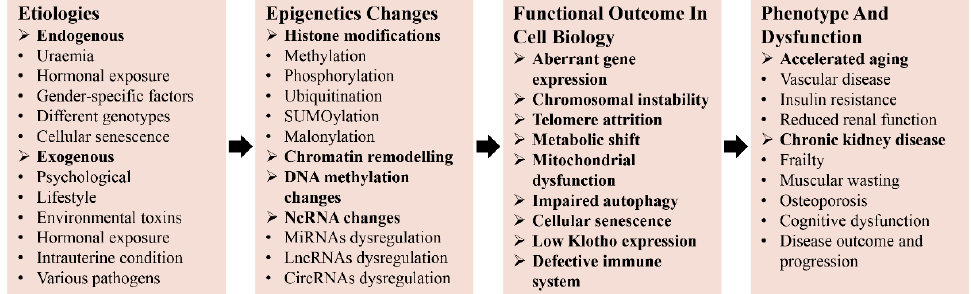
Figure 2. The epigenetic landscape mediates the interplay between etiologies and age-related renal dysfunctions. Both exogenous and endogenous etiologies can lead to changes in the epigenetic landscape that impact renal aging and physiology.